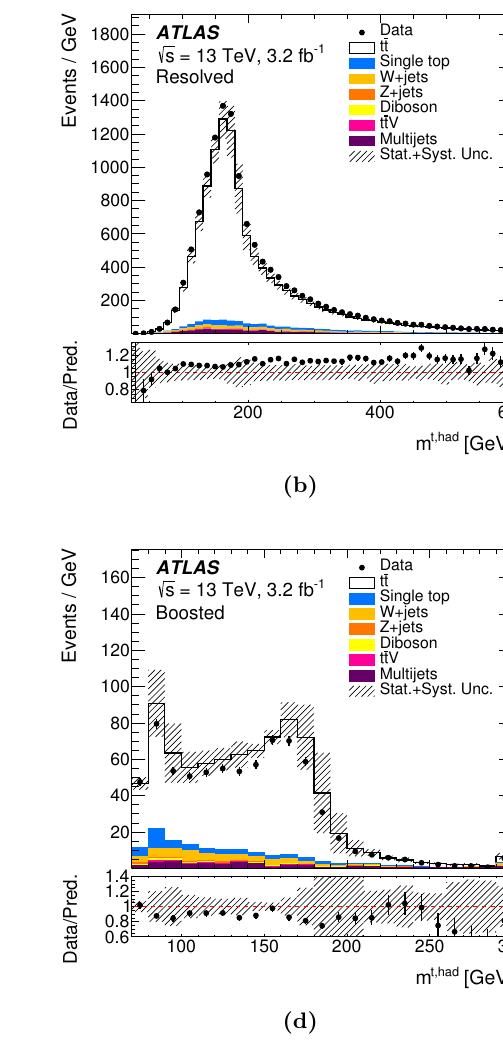
Figure 5. Kinematic distributions in the combined ‘ +jets channel at detector level: reconstructed masses of the (a) leptonic and (b) hadronic top quark candidates in the resolved topology; (c) hadronic top candidate (cid:28) 32 and (d) mass in the boosted topology. Data distributions are compared to predictions using Powheg + Pythia6 as the t (cid:22) t signal model. The hatched area indicates the combined statistical and systematic uncertainties in the total prediction, excluding systematic un- certainties related to the modelling of the t (cid:22) t system. Events beyond the range of the horizontal axis are included in the last